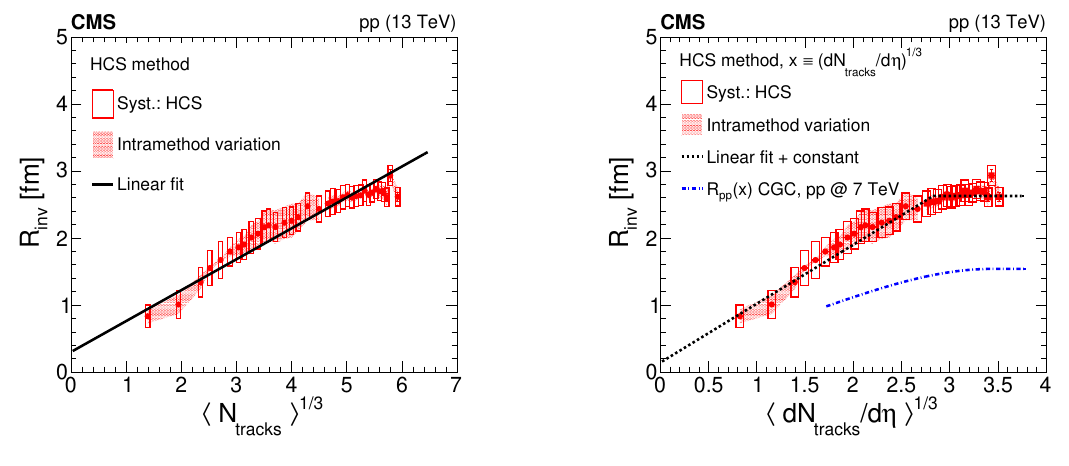
Figure 6 . Comparison of R obtained with the HCS method with theoretical expectations. Values inv of R as a function of h N i 1 = 3 (left) are shown with a linear (cid:12)t to illustrate the expectation inv tracks from hydrodynamics. Values of R are compared with predictions from the CGC as a function of inv h d N = d (cid:17) i 1 = 3 (right). The dot-dashed blue line is the result of the parameterization in eq. (7.1). tracks The linear plus constant function (dashed black lines) for h d N = d (cid:17) i 1 = 3 is shown to illustrate tracks the qualitative behavior suggested by the CGC (the matching point of the two lines is the result of a (cid:12)t). Only statistical uncertainties are